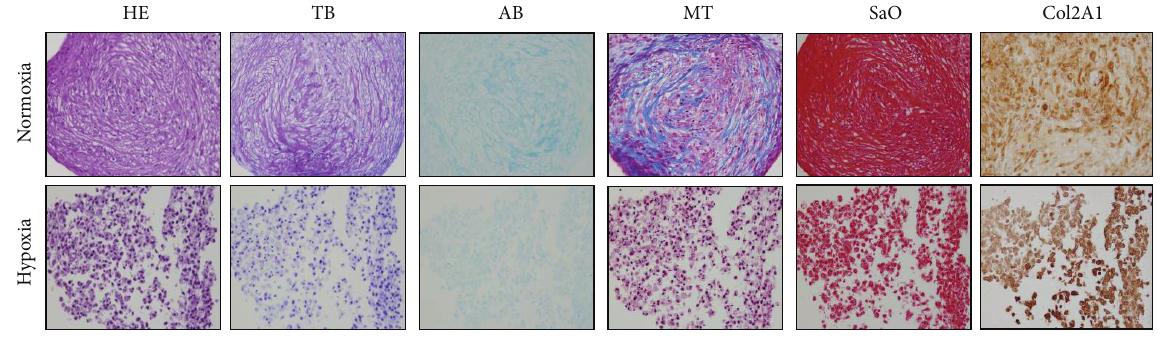
Figure 4: Histochemical (HE: hematoxylin-eosin; TB: toluidine blue; AB: alcian blue; MT: Masson’s trichrome; SaO: safranin O) and immunohistochemical results for collagen type 2 (Col2A1) cells differentiated toward chondrocytes. The photos are relative to day 14 of cultures in chondrogenic differentiation medium in normoxic conditions (up) and in hypoxic conditions